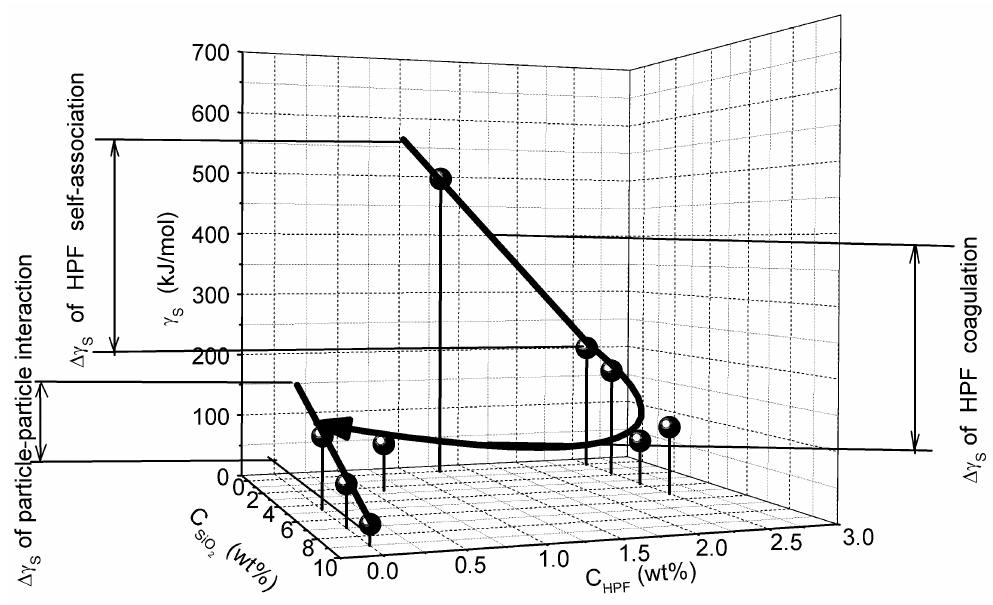
Fig. 8 Interfacial energy γ S as a function of concentration of HPF and silica.